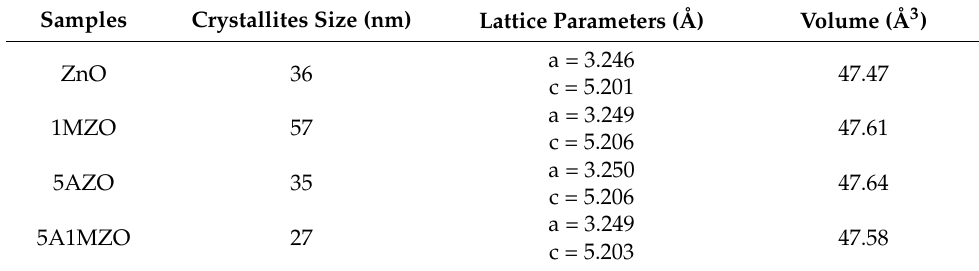
Table 1. Calculated results of crystallite size, lattice parameters and volume of the ZnO, 1MZO, 5AZO and 5A1MZO samples.